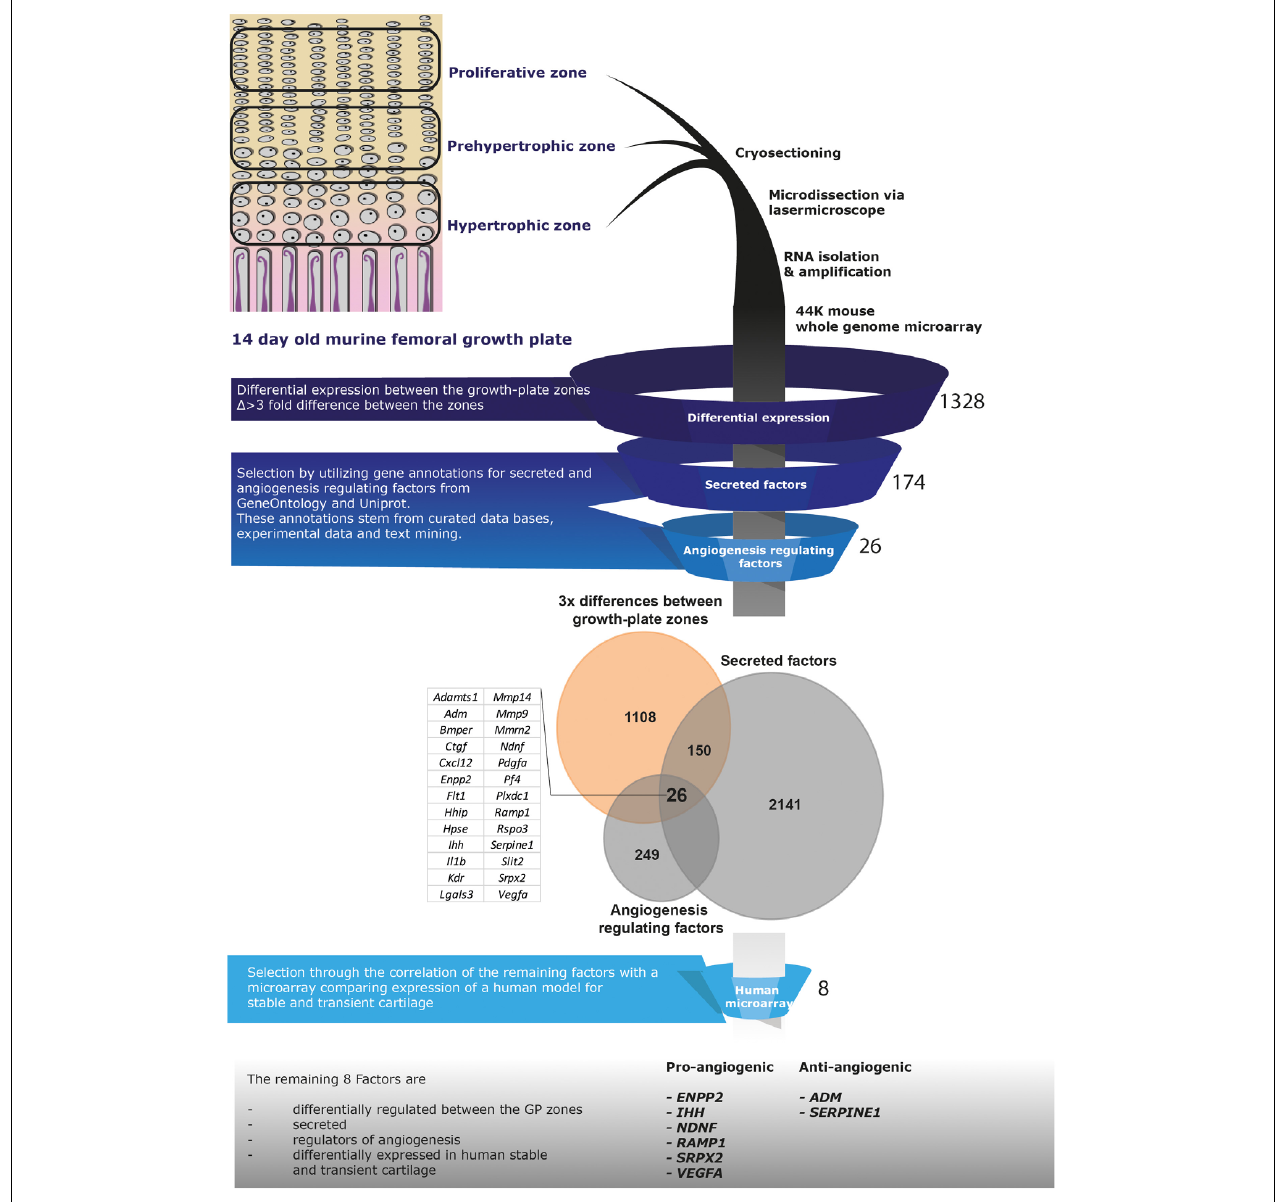
FIGURE 4 | Selection pipeline for factors of interest. Diagram of the selection process of factors of interest starting from a growth plate microarray going through the selection of secreted, angiogenesis regulating factors via online resources ending at the comparison to a human dataset including neonatal cartilage and chondrogenically differentiated BMSC data. Twenty-six factors were identified being differentially expressed between the growth plate zones, secreted and regulate angiogenesis (Venn-diagram). From these, 8 factors appeared differentially expressed between human chondrogenically differentiated BMSC and neonatal articular